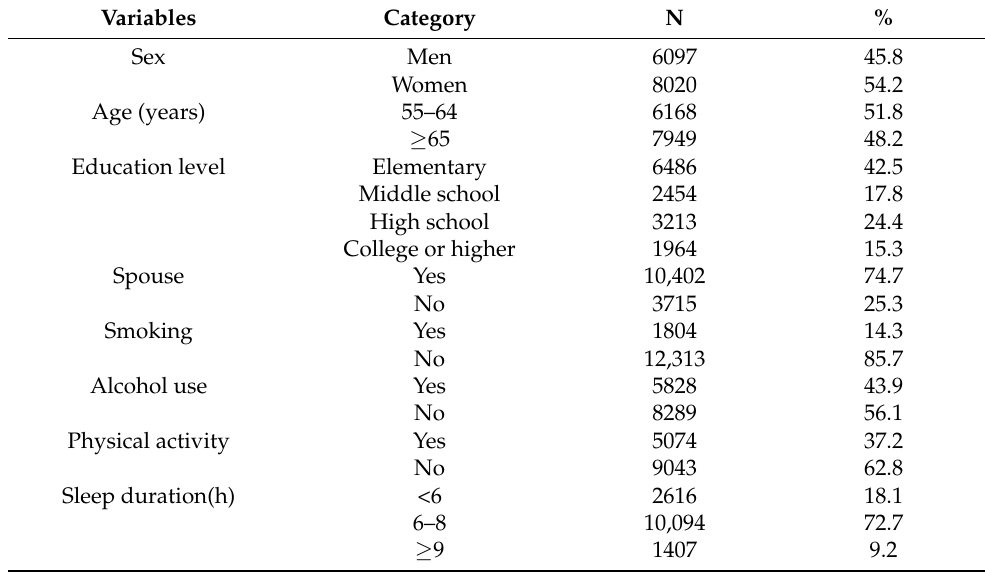
Table 1. General characteristics of